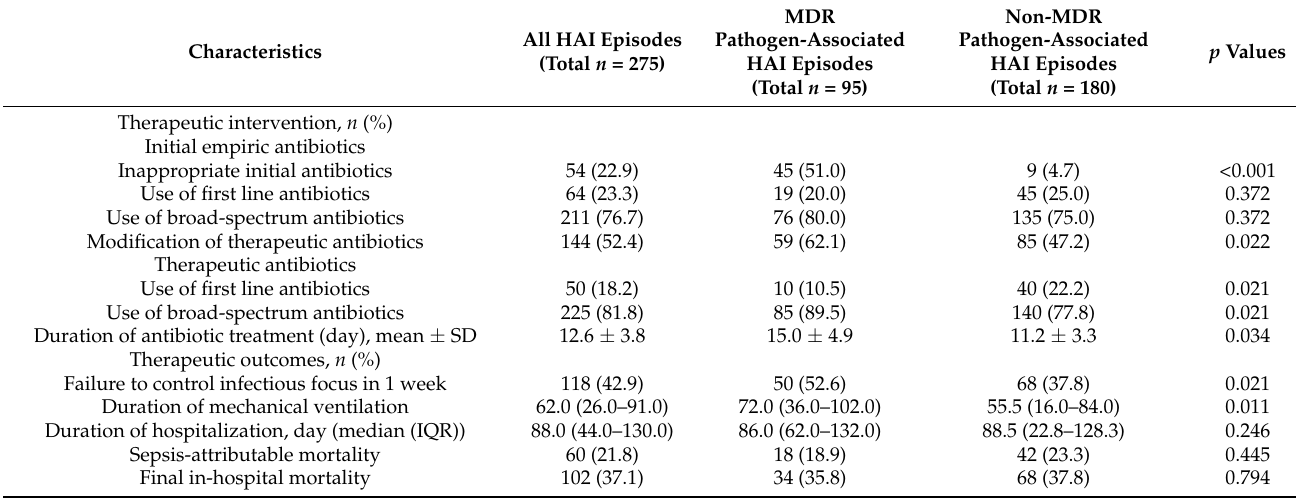
Table 3. Therapeutic intervention and outcomes of all neonatal healthcare-associated infections (HAIs) in neonates with severe respiratory failure in the CGMH from January 2014 to May 2020.